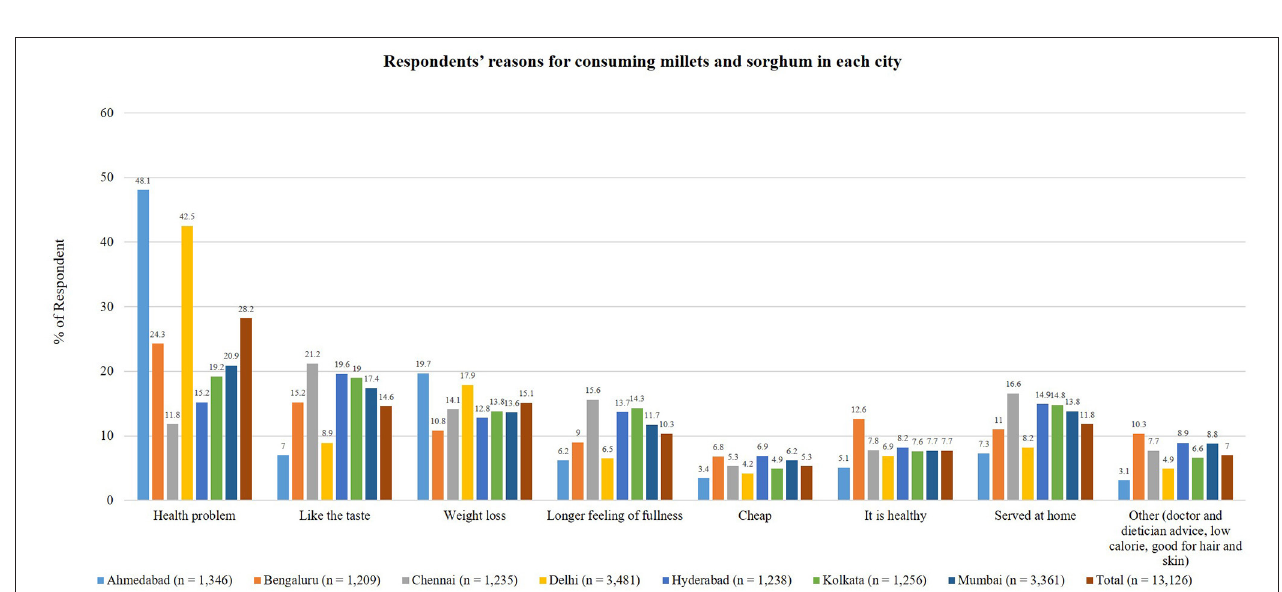
FIGURE 4 | Respondents reasons for consuming millets and sorghum in each